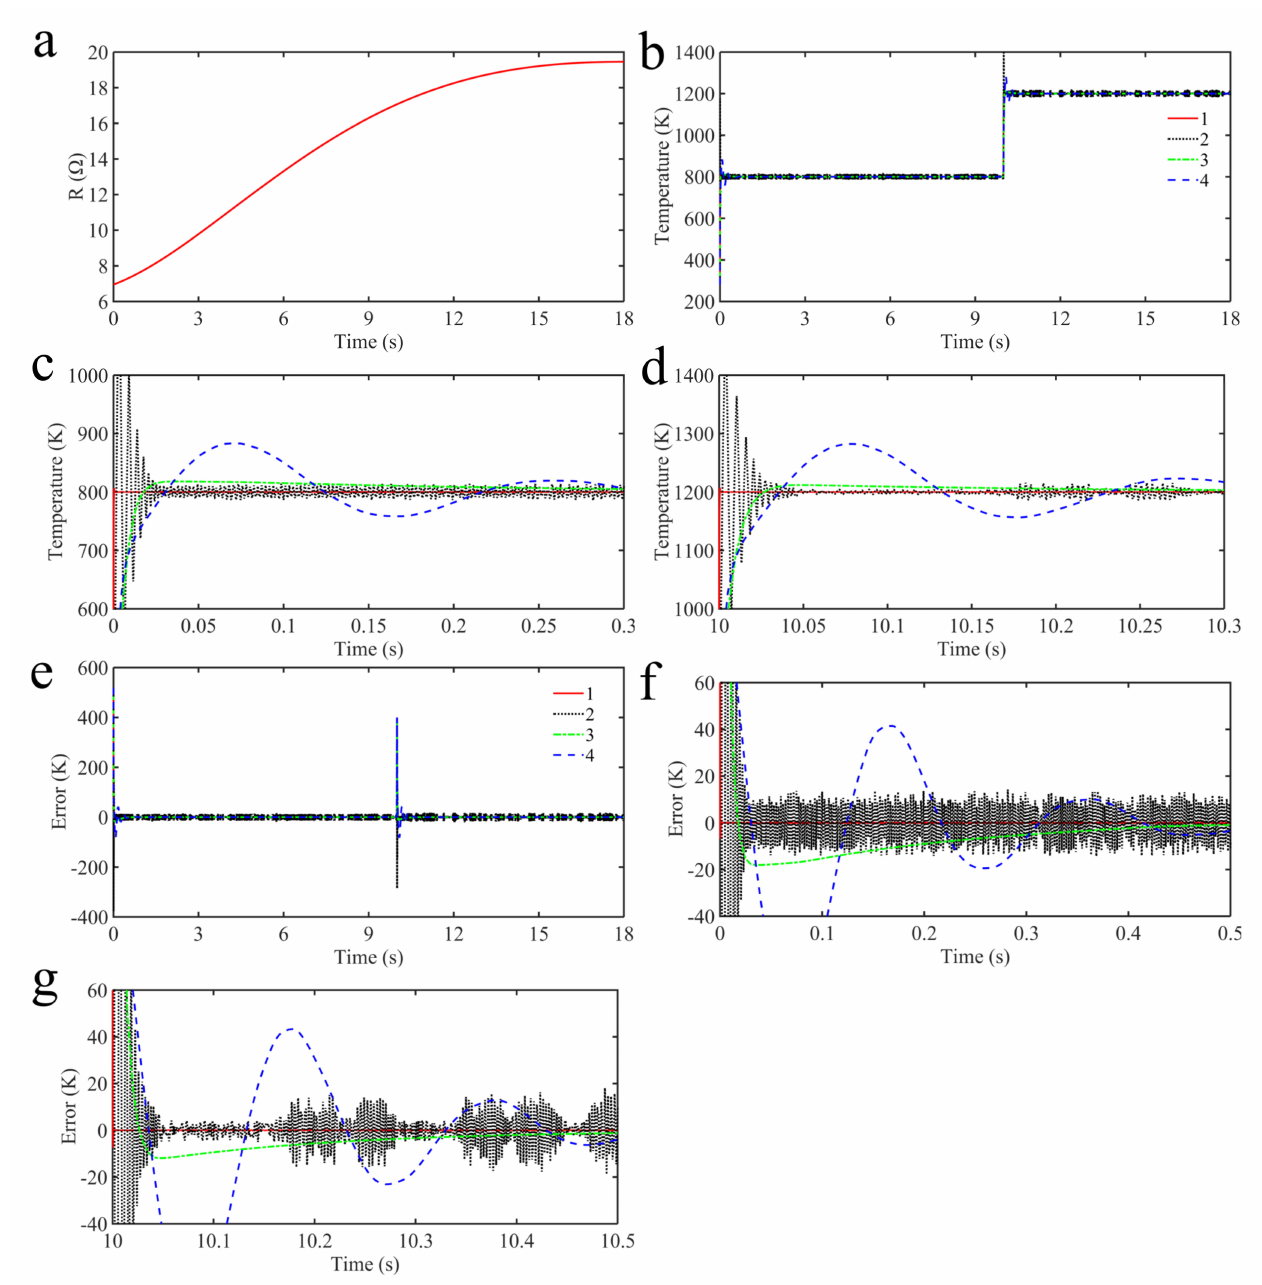
Figure 8. Simulation results with ( a ) extra disturbances: ( b ) tracking temperature trajectory; ( c ) and ( d ) partial enlarged drawings of tracking temperature trajectory; ( e ) tracking errors; ( f , g ) partial enlarged drawings of tracking errors among (1) STNFOSMCTDE, (2) LFOSMC, (3) IPID and (4)